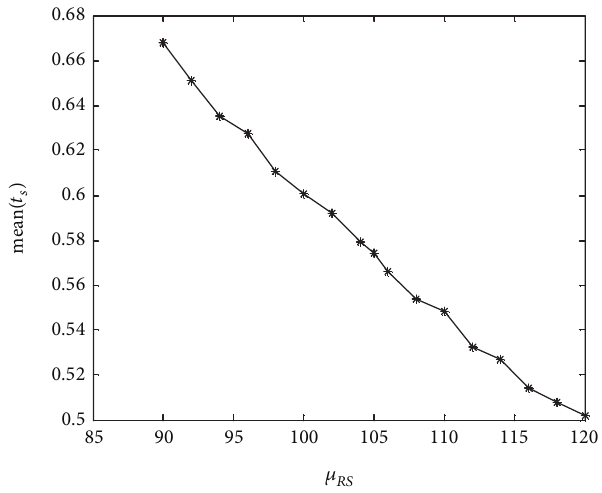
Figure 9: Mean of the supplier’s trust changes with 𝜇 𝑅𝑆